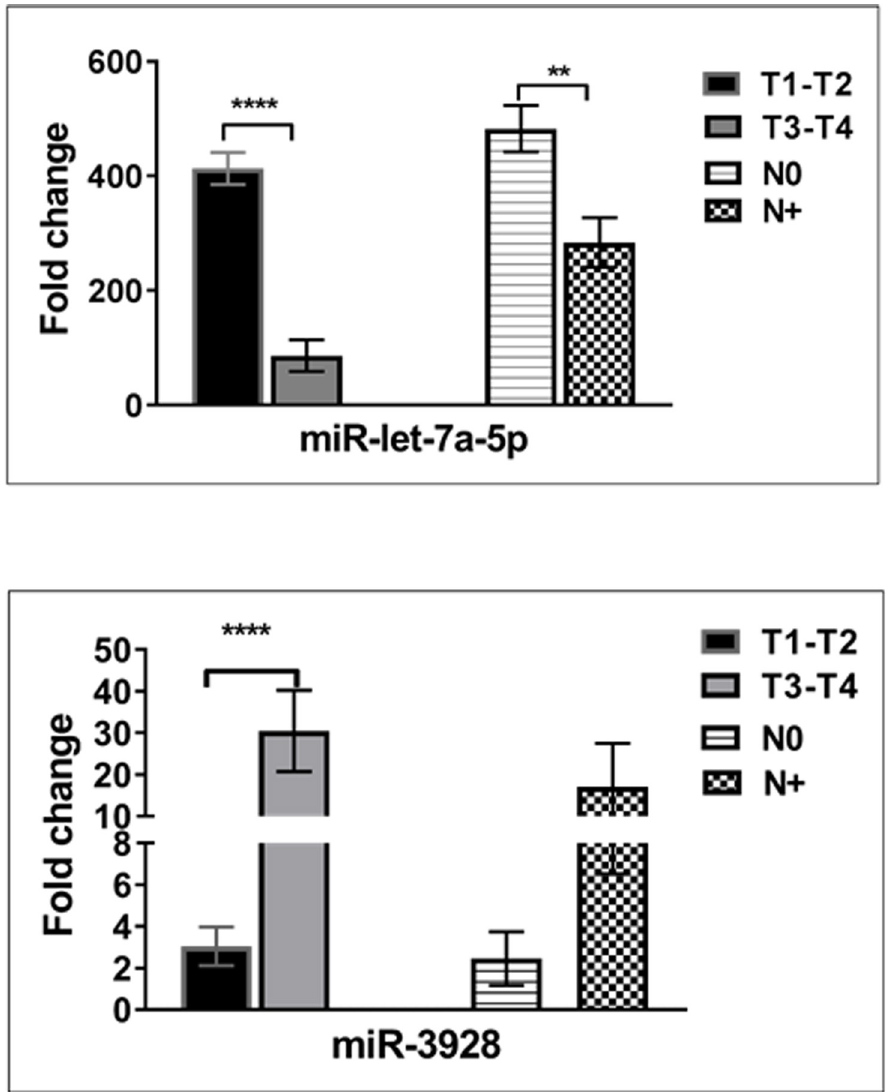
Significance of two-sided p-values indicated as follows: �� p < 0.01, ���� P < 0.0001 (t